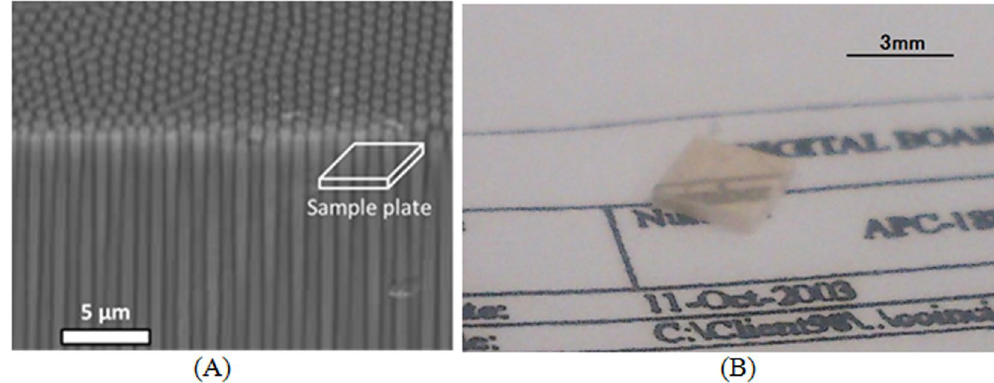
Figure 2. Schematic drawing of bird’s-eye view of SEM image of fiber scintillator plate ( A ). White fiber scintillators are GAP phase, and black matrices are α -Al 2 O 3 phase in the SEM image. Photo of fiber scintillator plate used for imaging system on piece of paper ( B ).